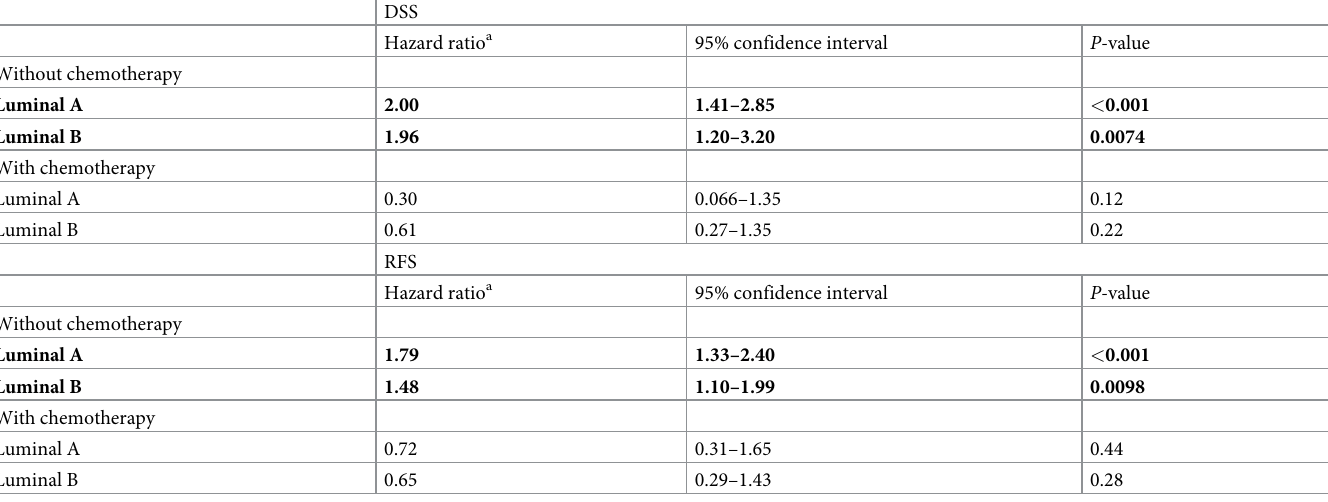
Table 5. Multivariate Cox regression analyses of disease-specific survival (DSS) or relapse-free status (RFS) in patients with luminal A and luminal B breast cancer without/with